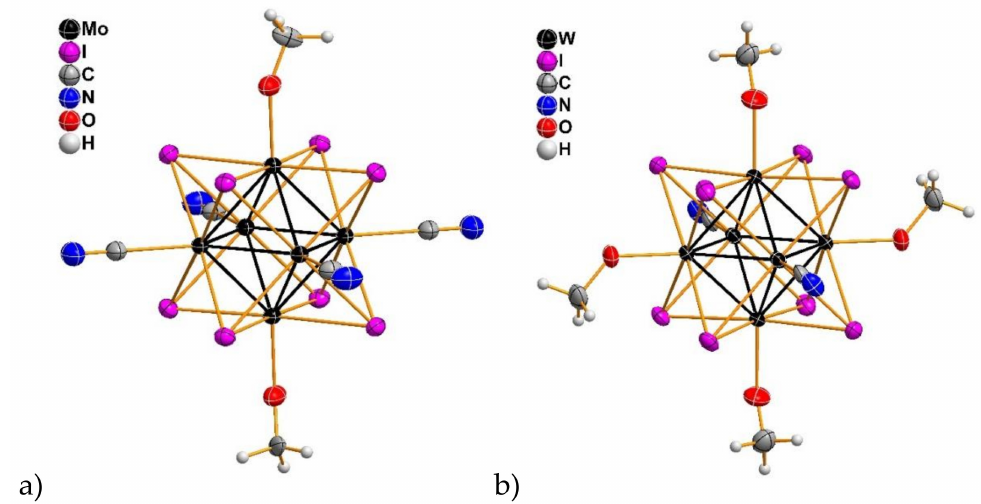
Figure 5. Structure of the [{Mo 6 I 8 }(CN) 4 (MeO) 2 ] 2 − cluster anions in the structure of compound 4 ( a ); structure of the [{W 6 I 8 }(CN) 2 (MeO) 4 ] 2 − cluster anion in the structure of compound 5 ( b ); atoms are shown as thermal ellipsoids of 50%